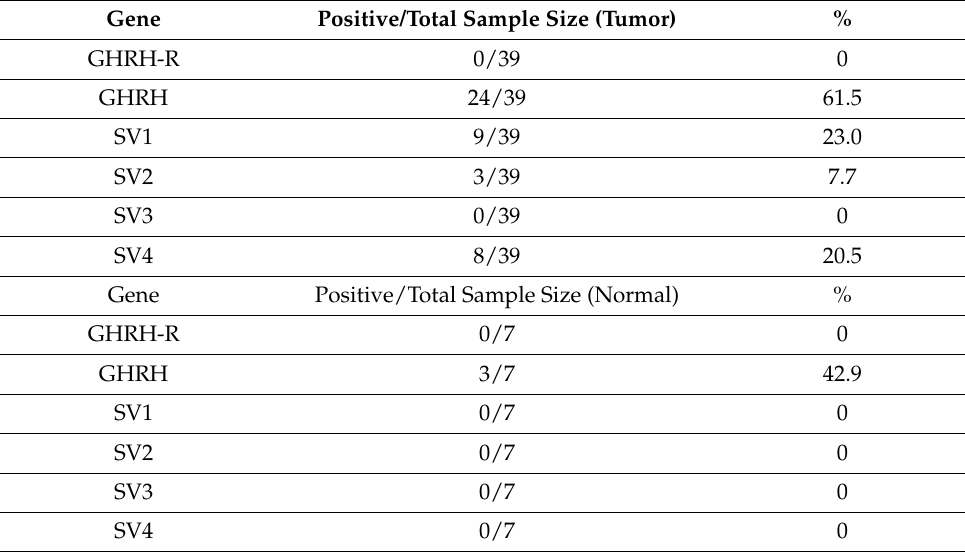
Table 1. Expression of mRNA for the full length GHRH receptor, its splice variants and the GHRH ligand in 39 human endometrial carcinoma samples and 7 normal human endometrial tissue samples.